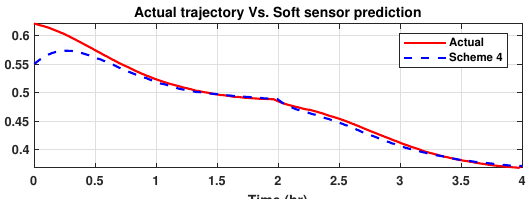
Figure 9. Trajectories of the actual states X B 3 and the predicted target variable using the soft sensor in Scheme